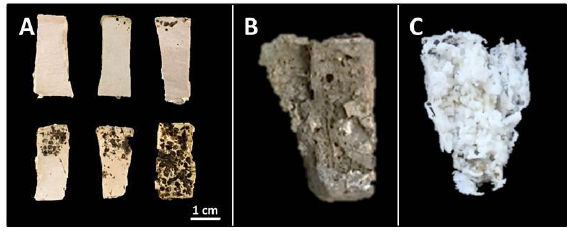
Figure 4. A – Increasing bioerosion levels observed in sections of mosaic tesserae; B - Tessera with sponge pitting; C - Silicon cast of the bioerosion pattern of the tessera in Fig.